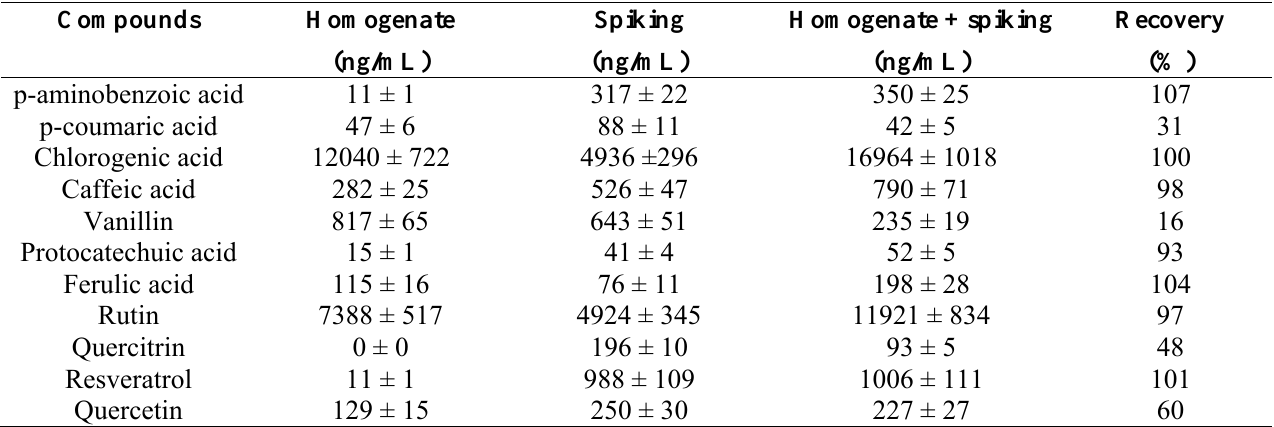
Table 5. Recovery of 20:20:60% – Water, Acetone,